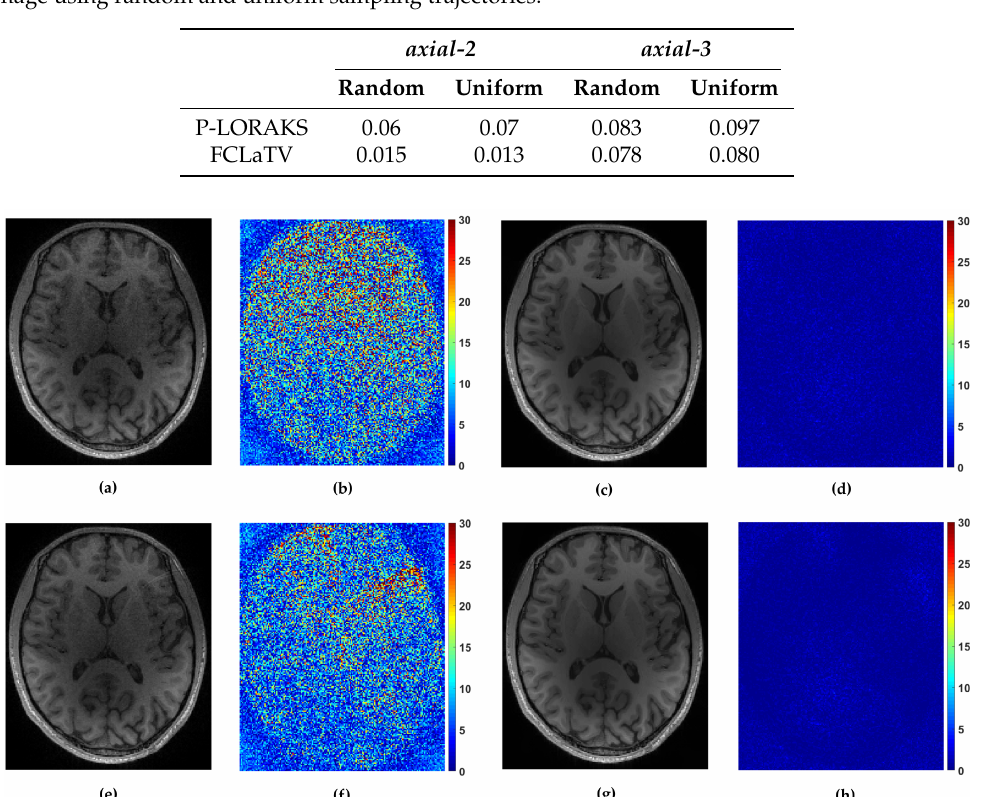
Figure 7. Reconstruction of axial-2 from randomly and uniformly sampled measurements from 4 coils. ( a , c ) Reconstructed images with P-LORAKS and FCLaTV method respectively from randomly sampled measurements with their ( b , d ) corresponding errors. ( e , g ) Reconstructed images with P-LORAKS and FCLaTV method respectively from uniformly sampled measurements with their ( f , h ) corresponding